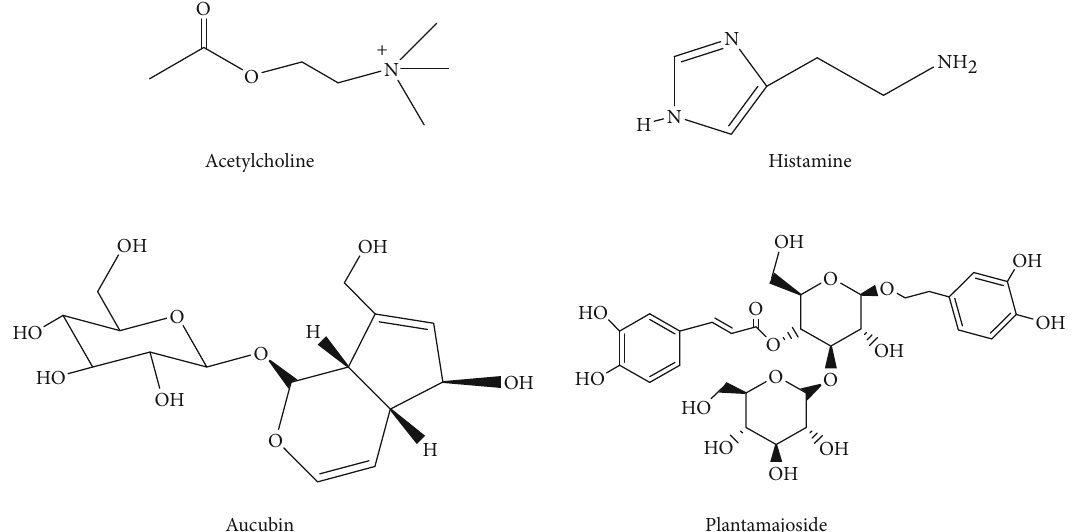
Figure 2: Structures of bioactive compounds used as antispasmodic activity.